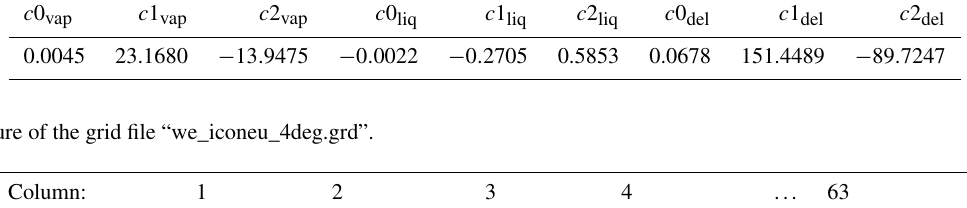
Table 2. Retrieval coefficients used (in centimeters). c 0 vap